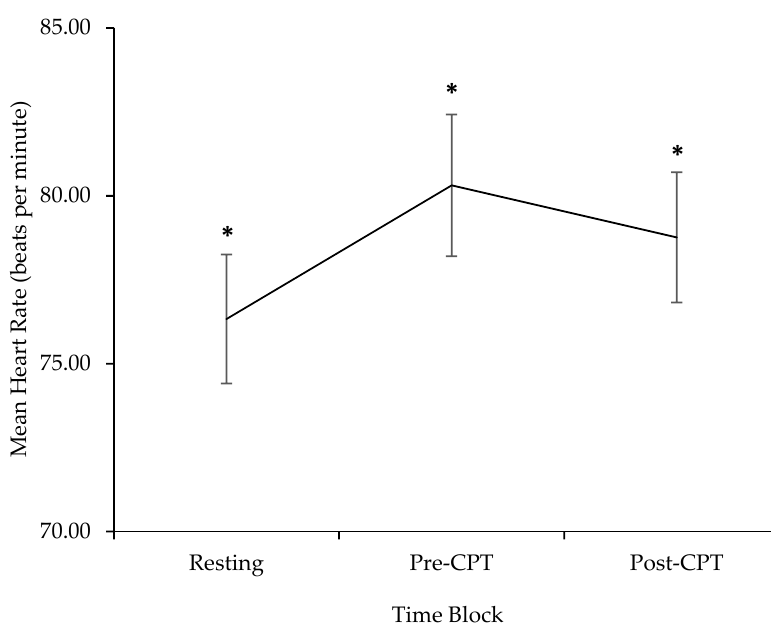
Figure 2. HR activity (beats per minute) during resting, pre-CPT and post-CPT. Bars represent standard error. Asterisks indicate significant differences between blocks, * p < 0.05.